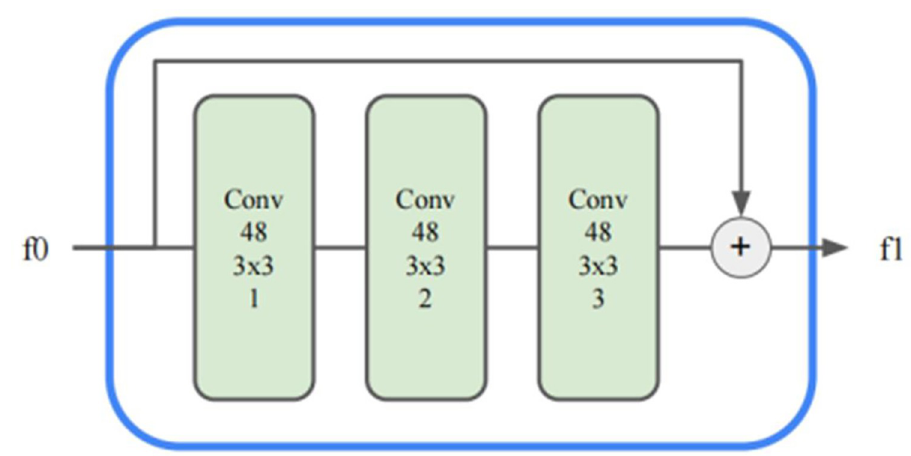
Fig 4. Structure of the hybrid dilated convolution